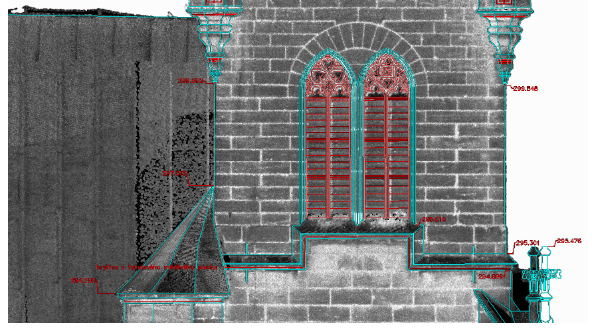
Figure 1. An orthoimage